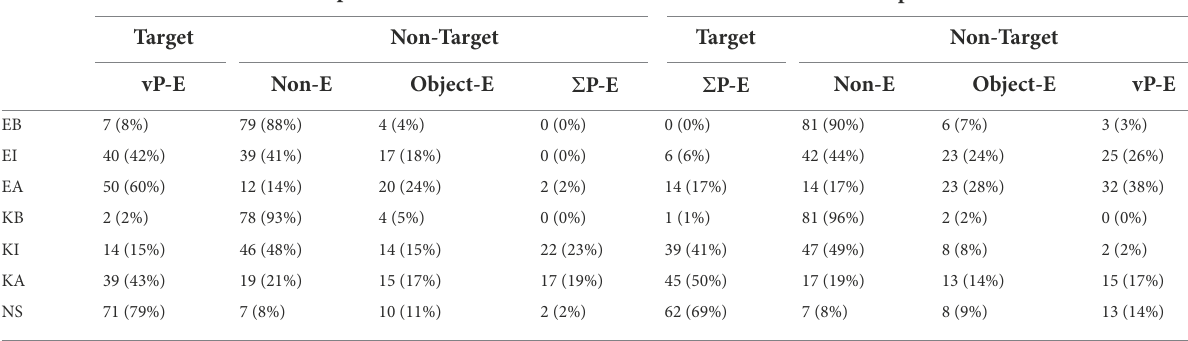
TABLE 4 The number of each response category in vP-ellipsis and Σ P-ellipsis conditions across groups (percentages in parentheses). vP-ellipsis Condition